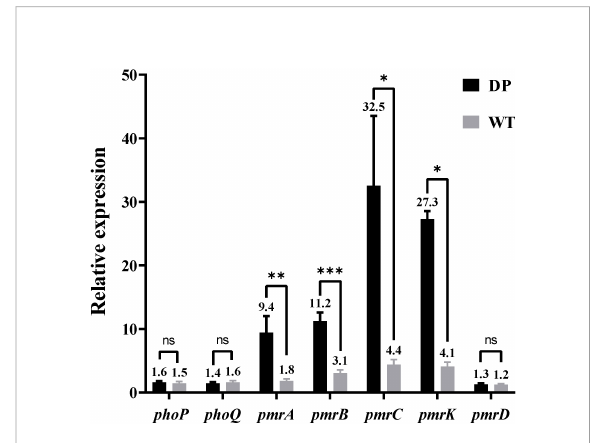
FIGURE 5 Comparison between the relative expression levels of the phoP , phoQ , pmrC , pmrA , pmrB , pmrK , and pmrD genes in strain DP and strain WT (Relative expression compared with K. pneumoniae ATCC13883, expression = 1). Values of relative expression are expressed as means and the standard deviation from experiments which were repeated in